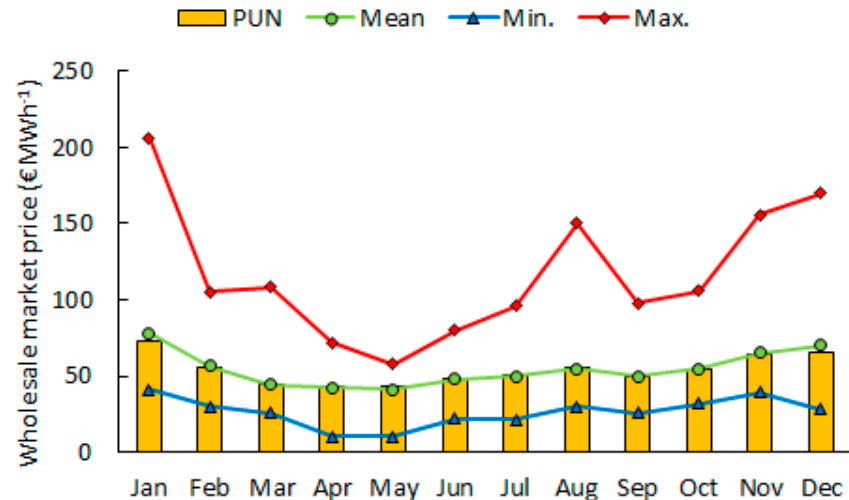
Figure 9. Electricity wholesale market price.